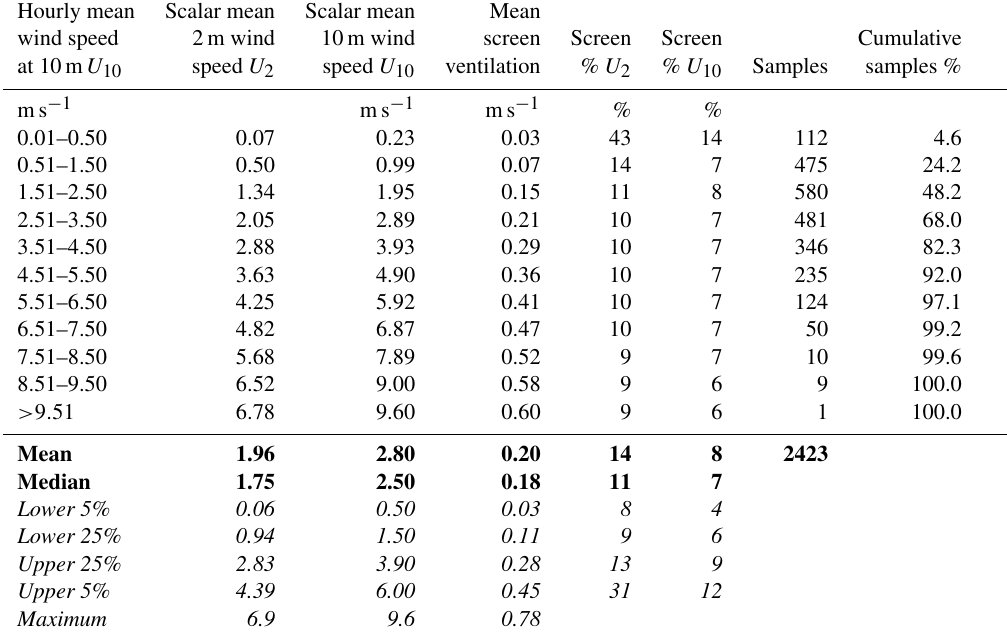
Table 1. Hourly scalar mean wind speeds at 2m and within the Stevenson screen for 1ms − 1 bins of 10m hourly scalar mean wind speeds during the analysis period, 13 February to 27 May 2020, at the University of Reading site. Screen airflow (as % external wind speed at 2 and 10m) excludes occasions when external wind speeds were logged as zero to avoid divide-by-zero errors. Note that the summary values include all data points; see Sect. 3.1.1 and 3.1.2 for differentiated < 1 and ≥ 1ms − 1 subsets with reasoning. Means and median values are shown in bold, and other measures of statistical distribution of the entire dataset are shown in